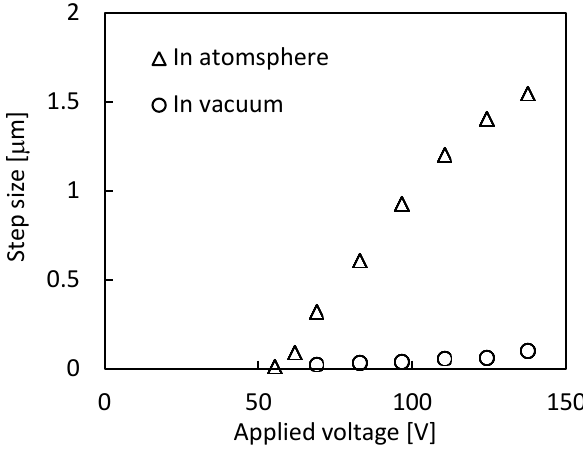
Figure 5. The variation of step size versus the applied voltage to PZTs-U and -D under atmospheric and vacuum